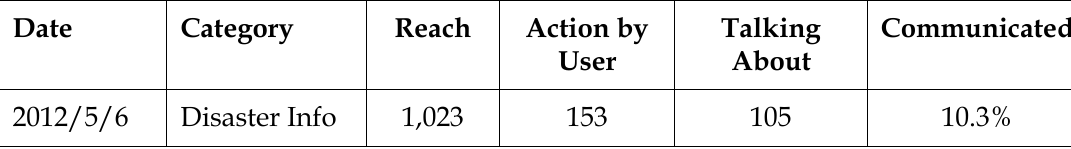
Table 3: Information about Posts during Tornado Disaster-Tsukuba Civic Activities